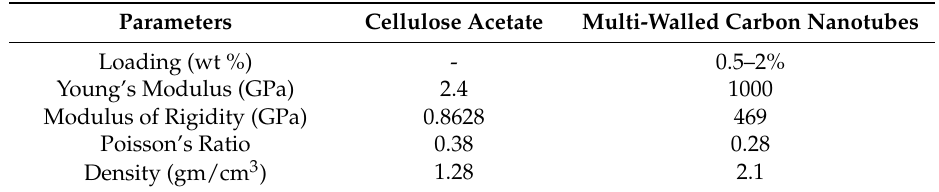
Table 2. Property values for matrix and inclusion.